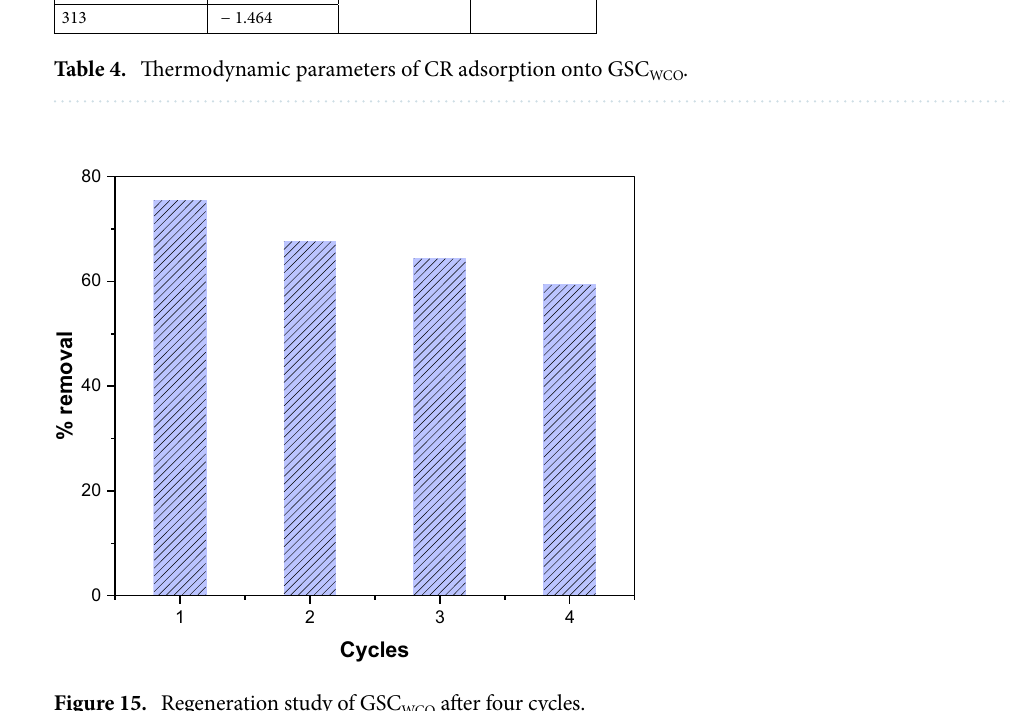
Figure 15. Regeneration study of GSC WCO after four cycles.